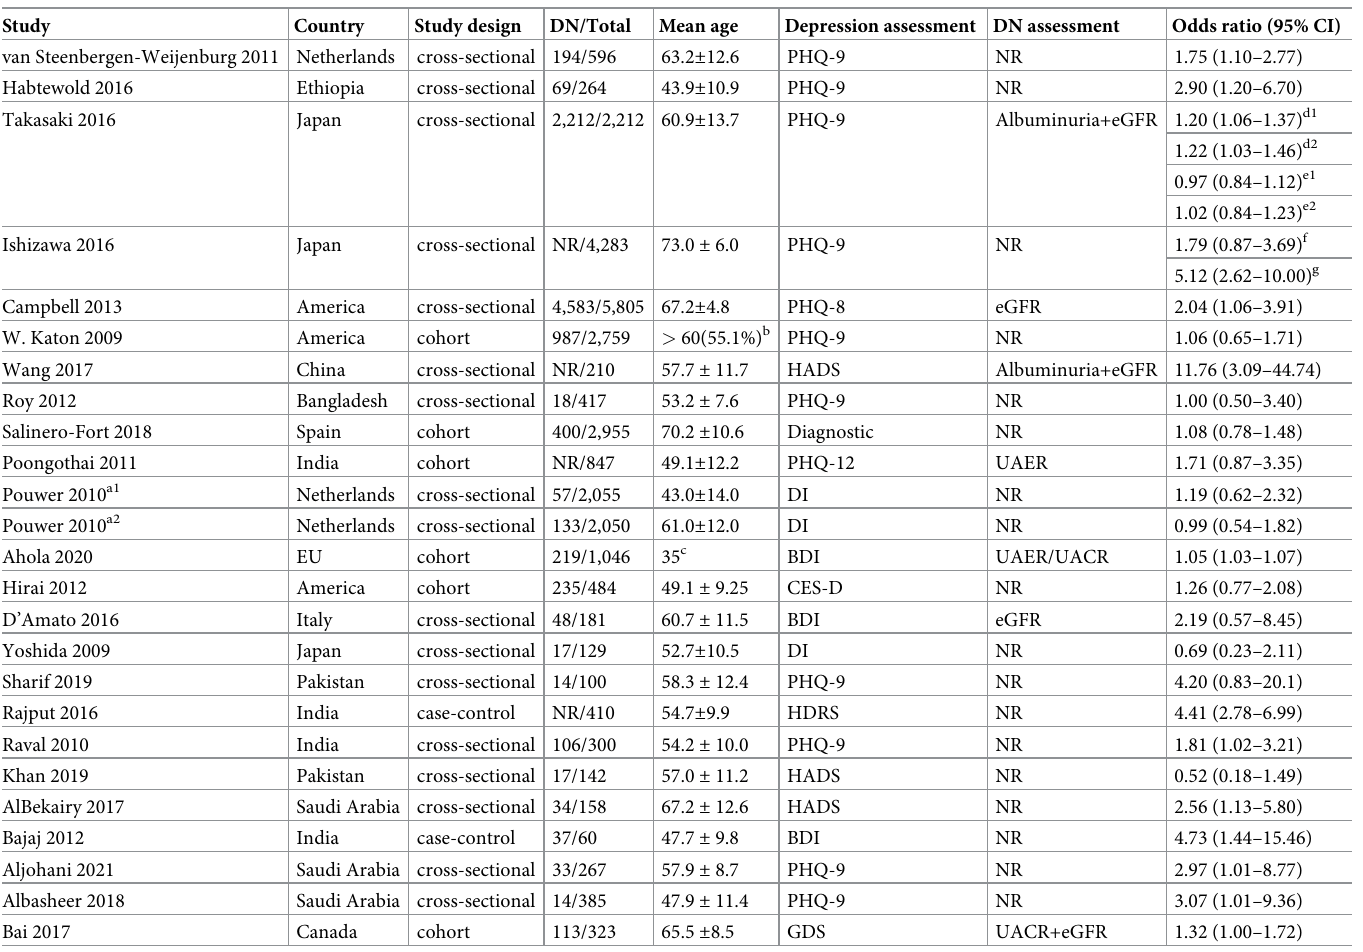
Table 1. Studies of diabetic nephropathy (DN) and incident